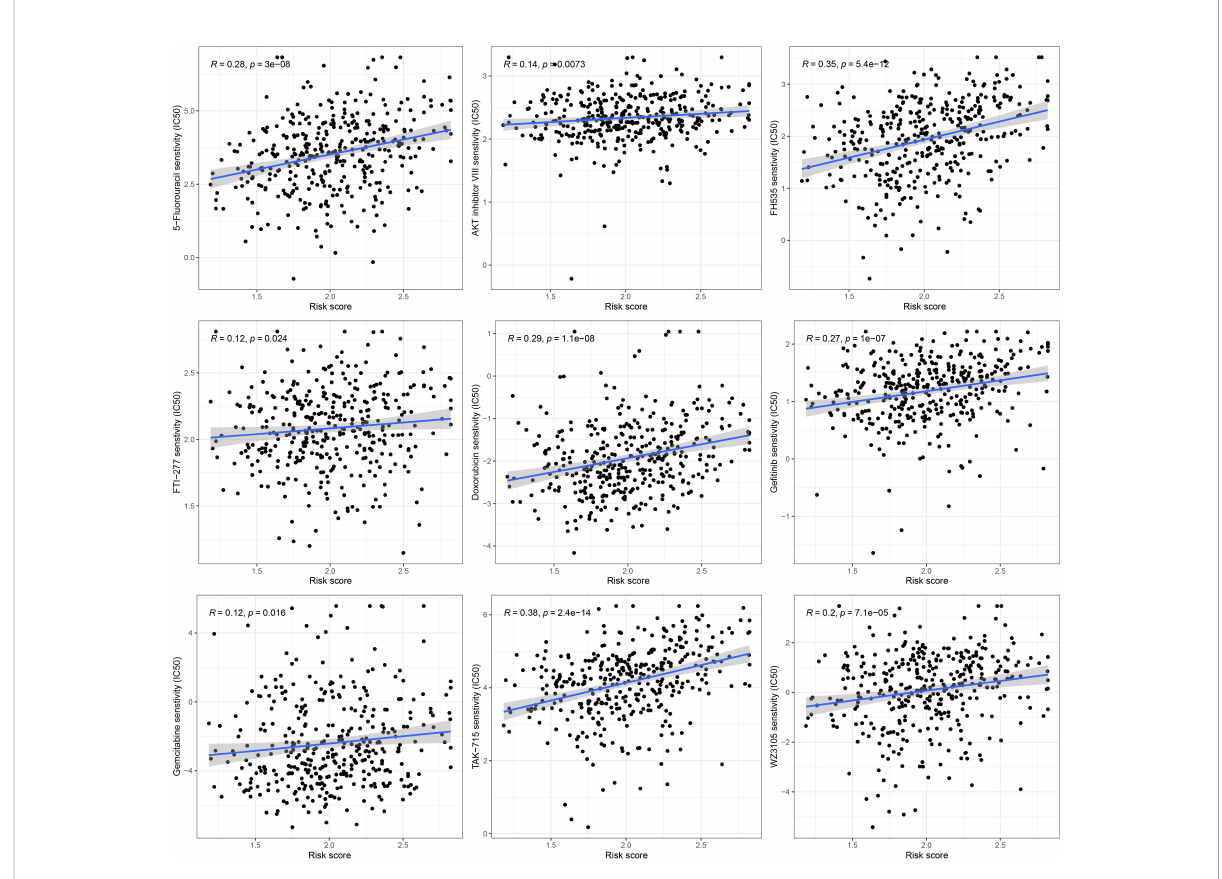
FIGURE 9 Drug sensitivity analysis in high and low risk